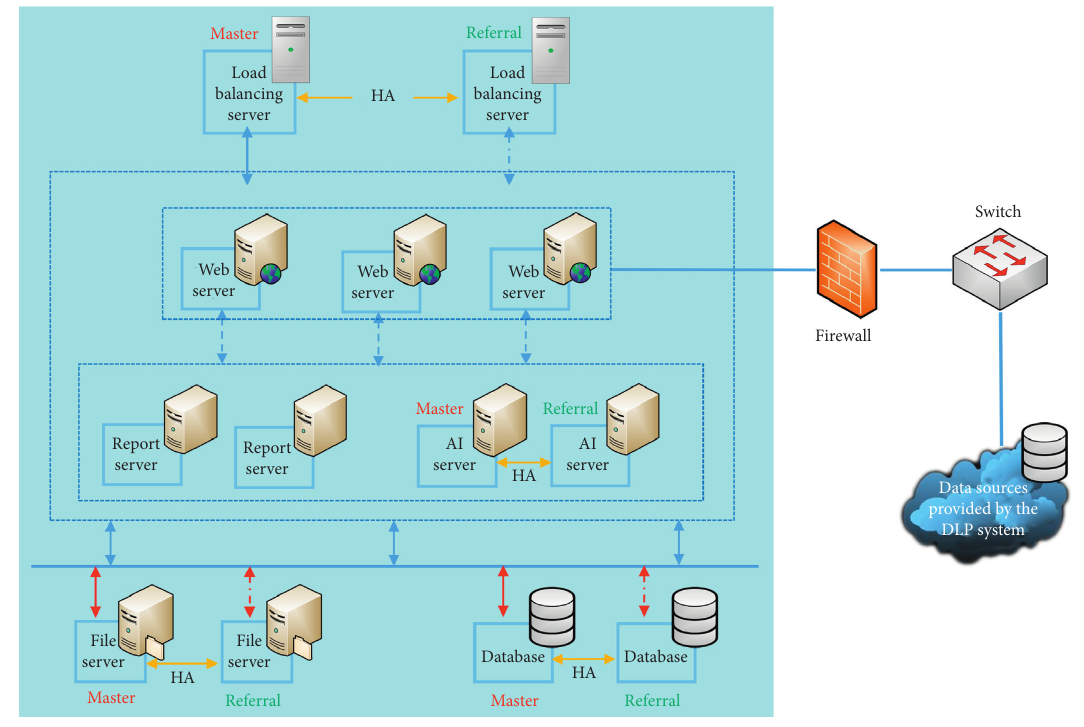
Figure 1: Classification and gradation system architecture diagram.